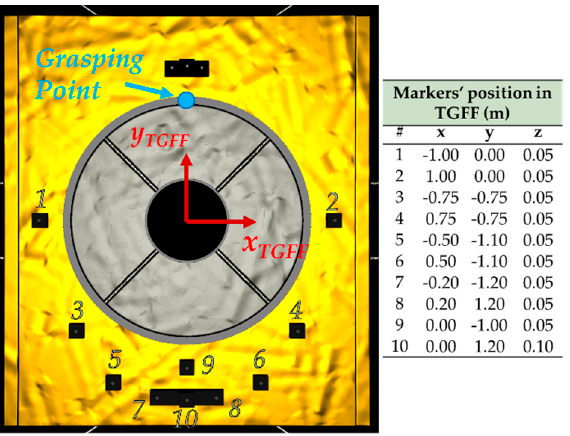
Figure 4. Pattern of markers employed on the target spacecraft for the CSFF–TGFF pose estimation, with indication of the position vectors in the